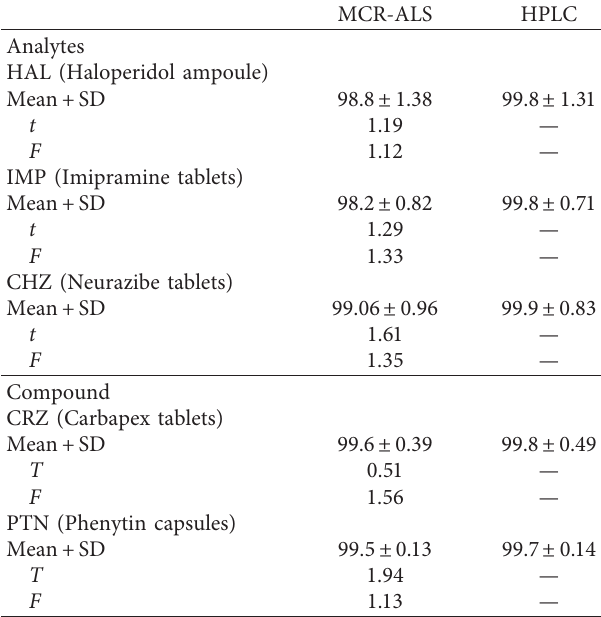
Table 4: Determination of the studied drugs in commercial products by the MCR-ALS method, the proposed method, and the reported HPLC